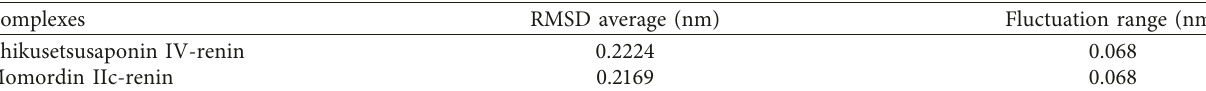
Figure 4: The RMSFs of complexes. Table 4: The RMSDs of complexes after 3000 ps.